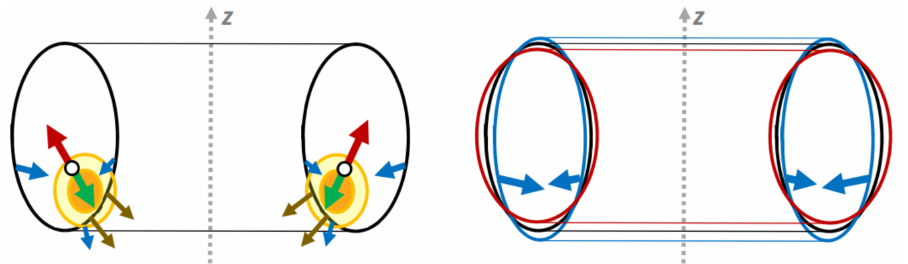
Figure 3. Schematic illustration of EM loads at VV during and after CQ: left side illustrates EM loads when plasma with the Halo layer still exists. Red arrow: interaction of poloidal halo current with toroidal field; green arrow: toroidal halo current with poloidal field; brown arrows: poloidal halo current in VV with toroidal field; blue arrow: toroidal currents in VV with poloidal field. Right side: blue arrows show “magnetic pressure” at VV due to interaction of toroidal currents in VV with poloidal field when plasma and the halo layer disappeared. The magnetic pressure causes slowly growing vertical net force at VV, but much faster it deforms VV structure, as shown by blue contour (relative black contour). Then VV vibrates, as shown by all three contours at the right. Since massive VV tends to keep its centre of mass in place, these vibrations add cyclic inertial forces at VV